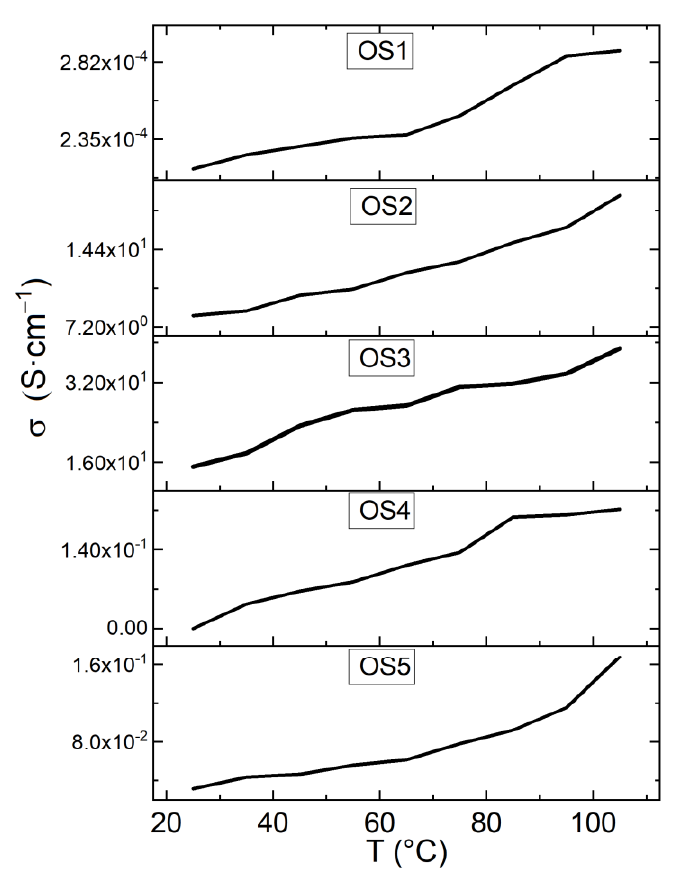
Figure 8. Electric conductivity (σ) vs. T of the devices with OS films.